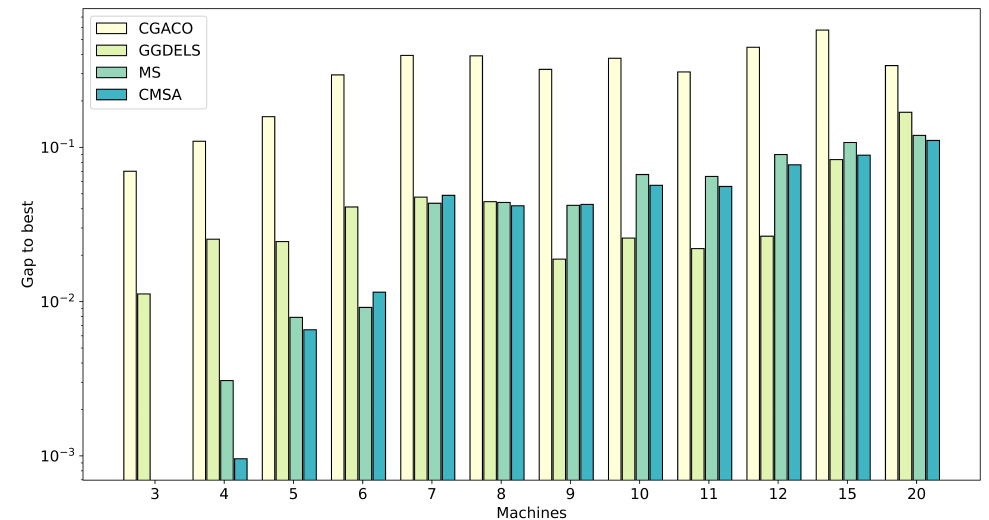
Figure 5. Comparison of the algorithms concerning the percentage difference to the best result, averaged over the instances with the same number of machines. The scale of the vertical axis is